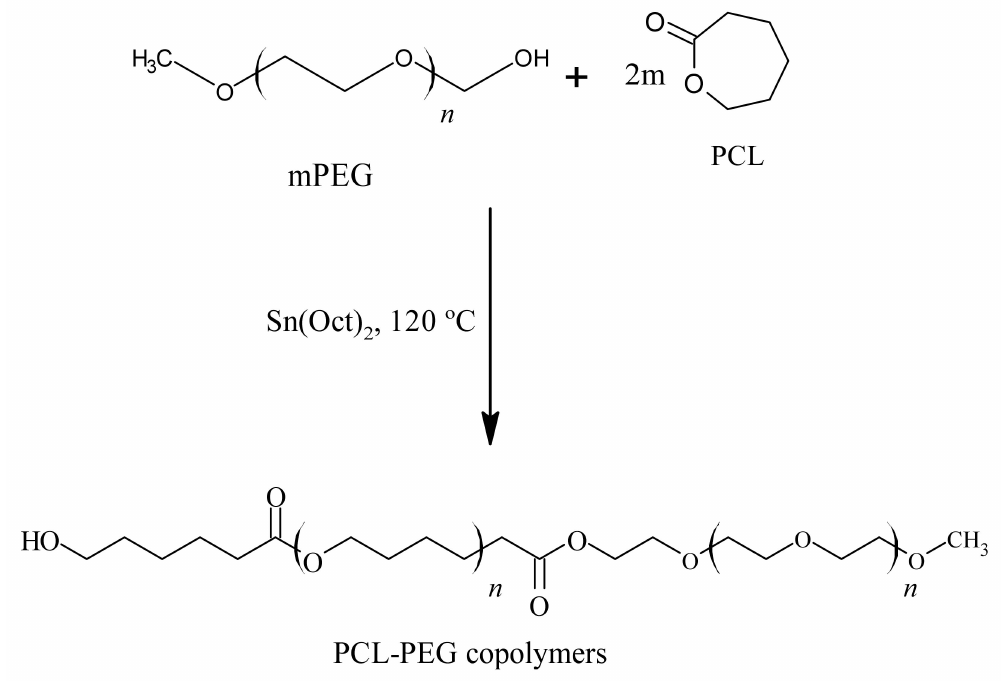
Figure 2. Schematic route for the preparation of PCL-PEG copolymers.